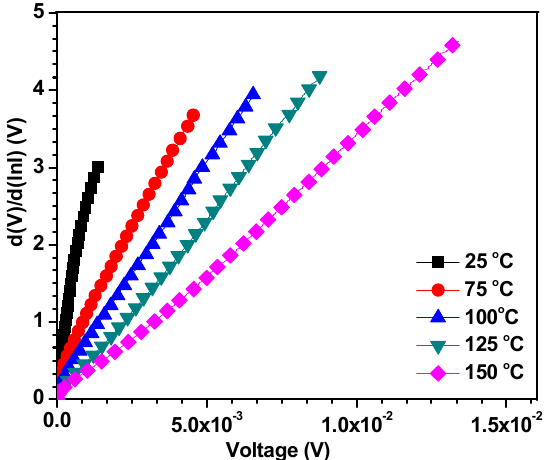
Figure 7. The reverse and forward current density–voltage (I–V) plots of the p-Sb 0.14 GaN/ n -Si het- erojunction diodes measured at the different temperatures, ranging from 25 °C to 150 °C.